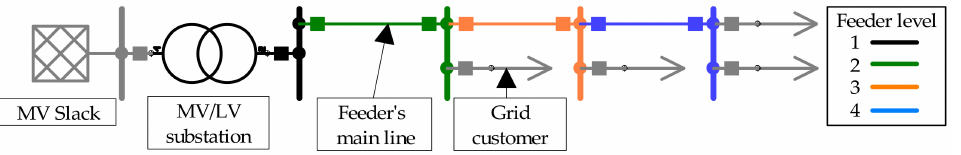
Figure 3. Structuring the grid topology into feeder